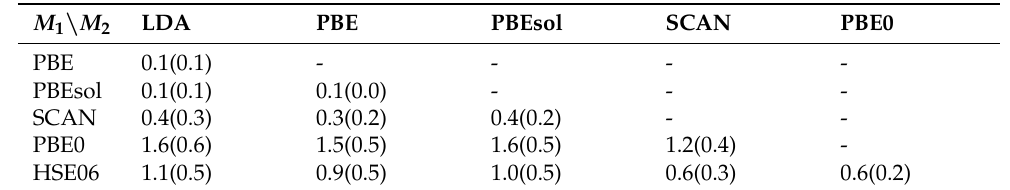
Table 3. The mean and the standard deviation of the probability distribution of having two DFAs giving similar results, µ s ( M 1 , M 2 )( σ s ( M 1 , M 2 )) , Equations (12) and (13). M 1 \ M